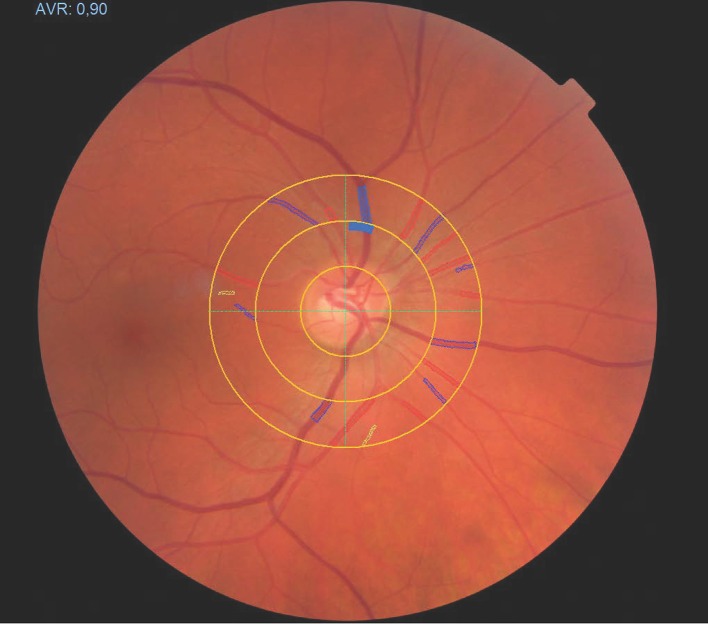
Fundoscopy of the human retina. A software-based identification of retinal vessels in ring-zones allows for measuring of arteriolar and venular diameters.